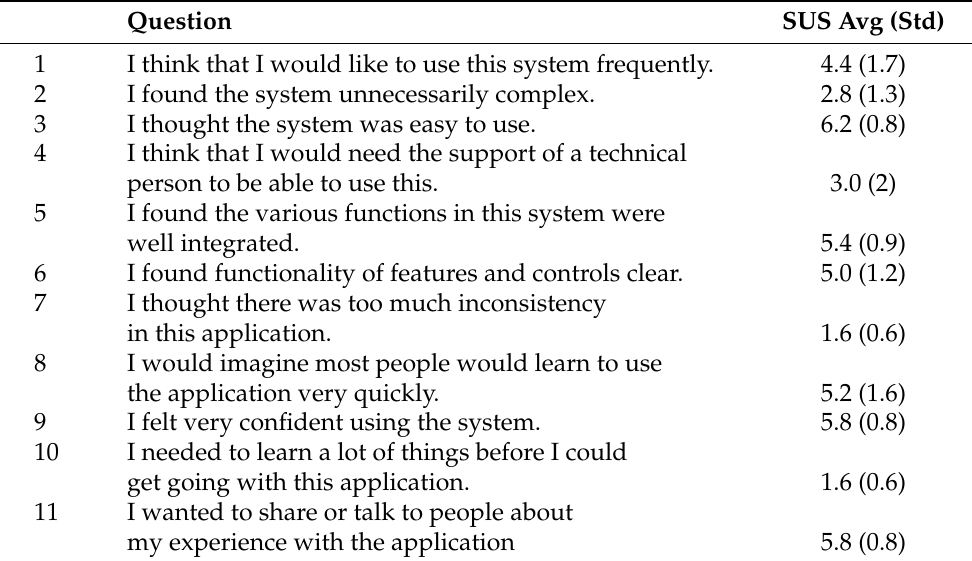
Table 2. Average system usability score for part 2 of the